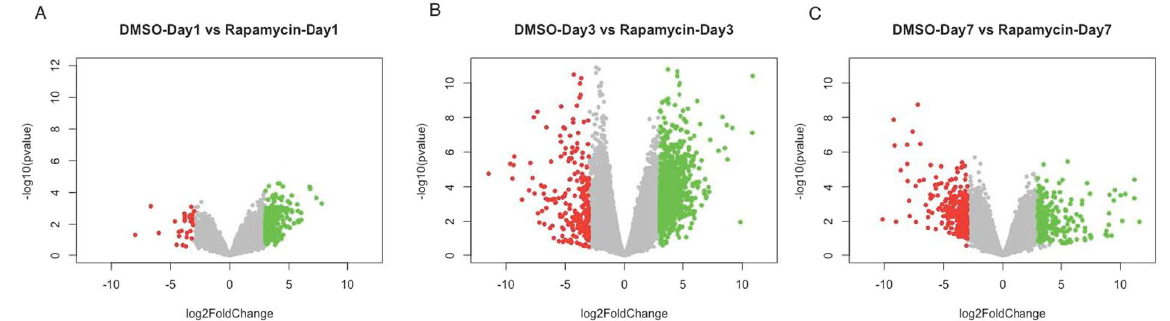
Figure 5. Volcano plots showing the pairwise comparison of differentially expressed genes (DEG) between DMSO-control and the rapamycin injected animals at Days 1 ( A ), 3 ( B ) and 7 ( C ). Up-regulated transcript abundance is indicated in green; down-regulated abundance in red. Highest numbers of DEGs were observed between DMSO-control vs rapamycin at Day 3.